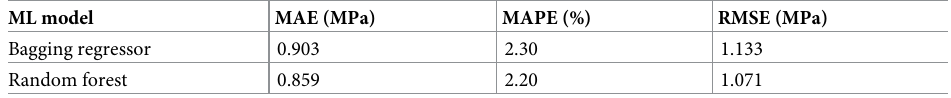
Table 1. Results of statistical checks for the ML models.